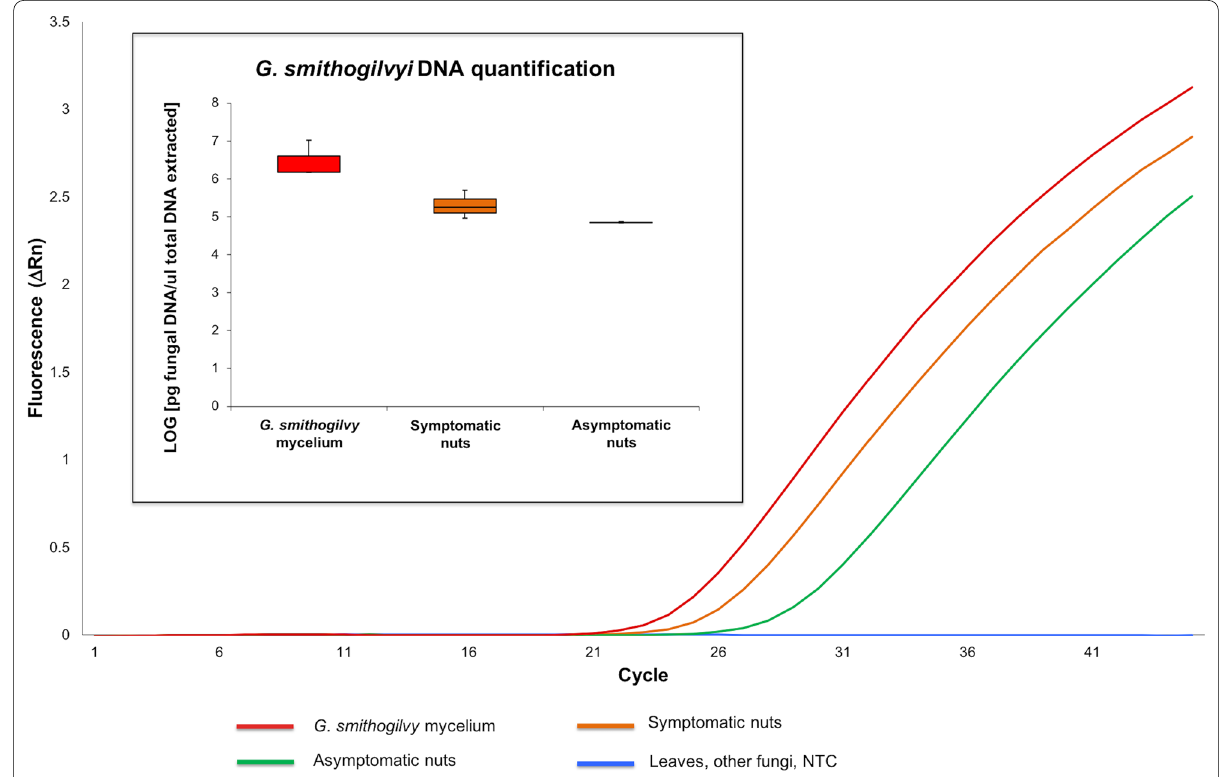
Fig. 4 Amplification plots of Gnomoniopsis smithogilvyi DNA in chestnut and mycelium samples using qPCR (TaqMan MGB probe). The box-plots inset show the quantification of fungal pathogen DNA in plant tissues (symptomatic and asymptomatic) in comparison with G. smithogilvyi mycelium from axenic culture. NTC No Template =